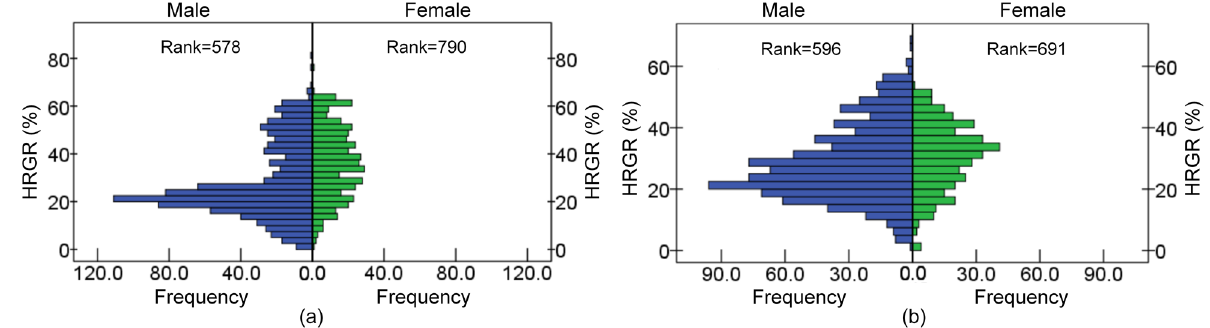
10 of 15 Figure 11. HRGR difference in driving experience during tasks: ( a ) Hands-free phone conversation, ( b ) slogan reading, and ( c ) chatting. However, HRGR of the novices was significantly lower than that of the experienced subjects under the chatting condition ( p = 0.000). The HRGR of the novices mainly ranged from 8% to 24%, while the experienced subjects ranged from 16% to 32%, which indicated the experienced drivers felt more nervous during chatting. 3.3.2. Gender During the hands-free phone conversation, the HRGR of male drivers was mainly distributed in 15–25% while, for female drivers, it was in 20–40%, as shown in Figure 12.